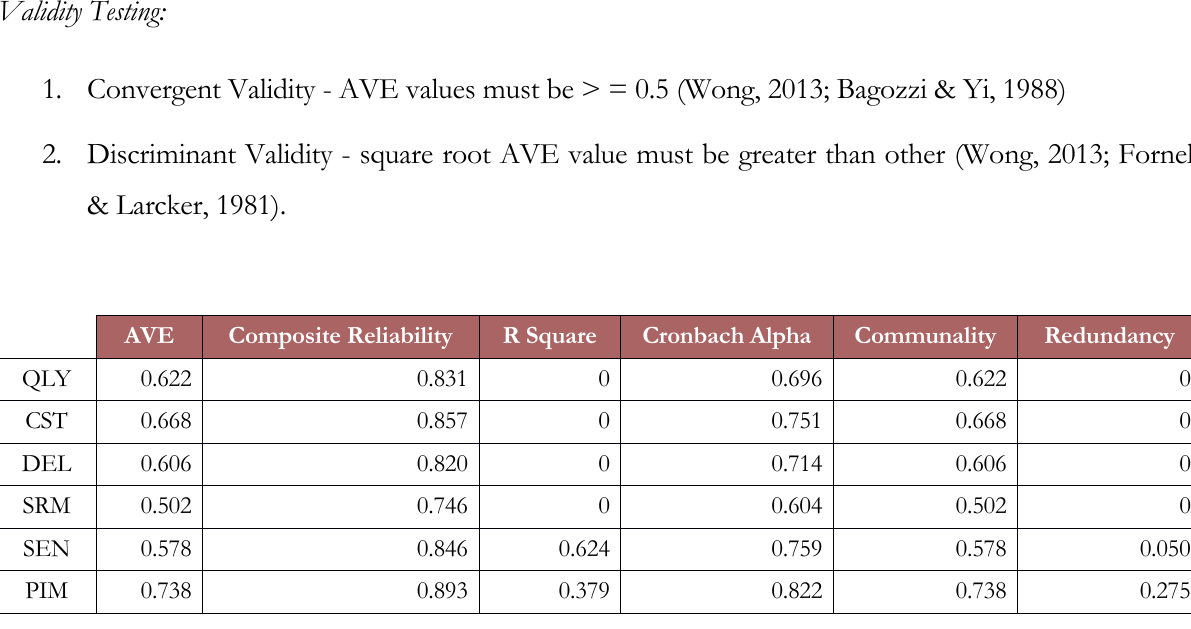
Table 4. Reliability